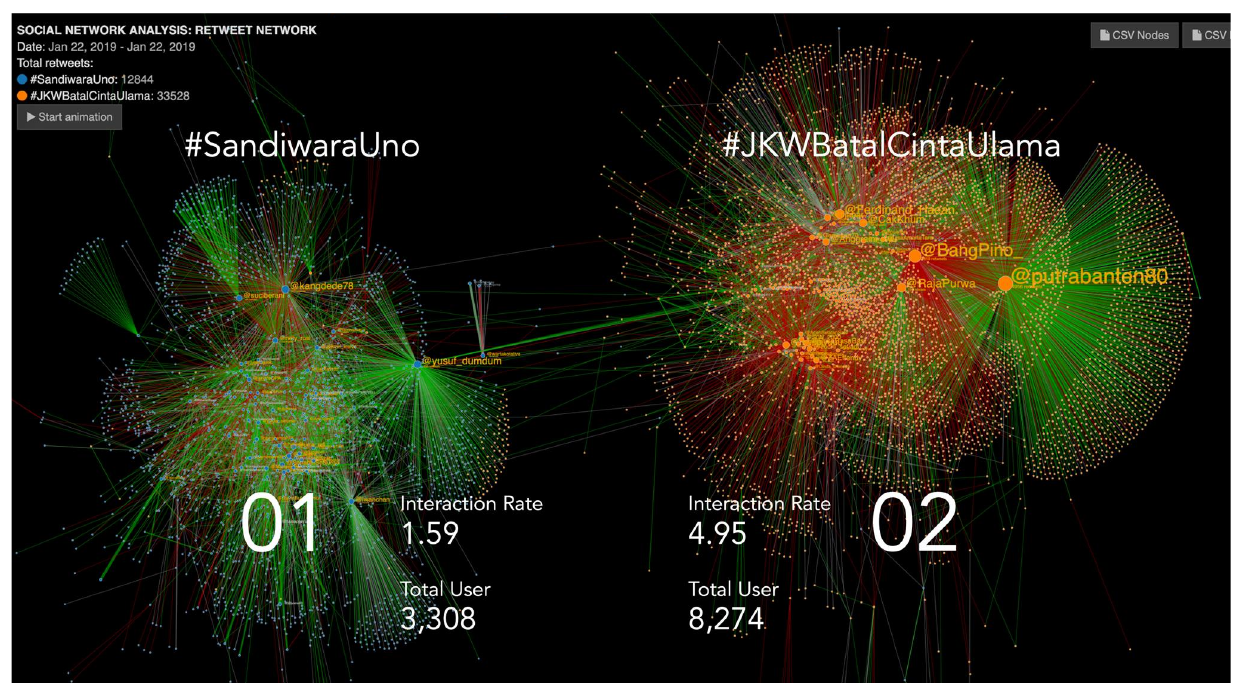
Figure 1. SNA (Social Network Analysis) map of netizens’ chats on Twitter referring to the hashtag wars between the number 01 Presidential Candidate pair (Jokowi-Ma’ruf Amin) and the number 02 Presidential Candidate pair (Prabowo- Sandiaga) on 22 January 2019. Source: DEA